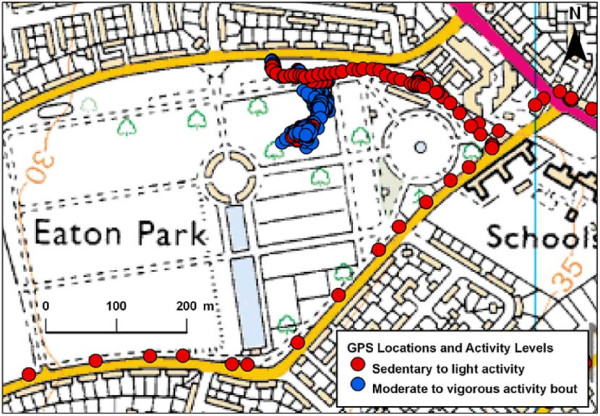
An example of a child visiting an urban park to play. Data Crown Copyright © Ordnance Survey. Used under license.